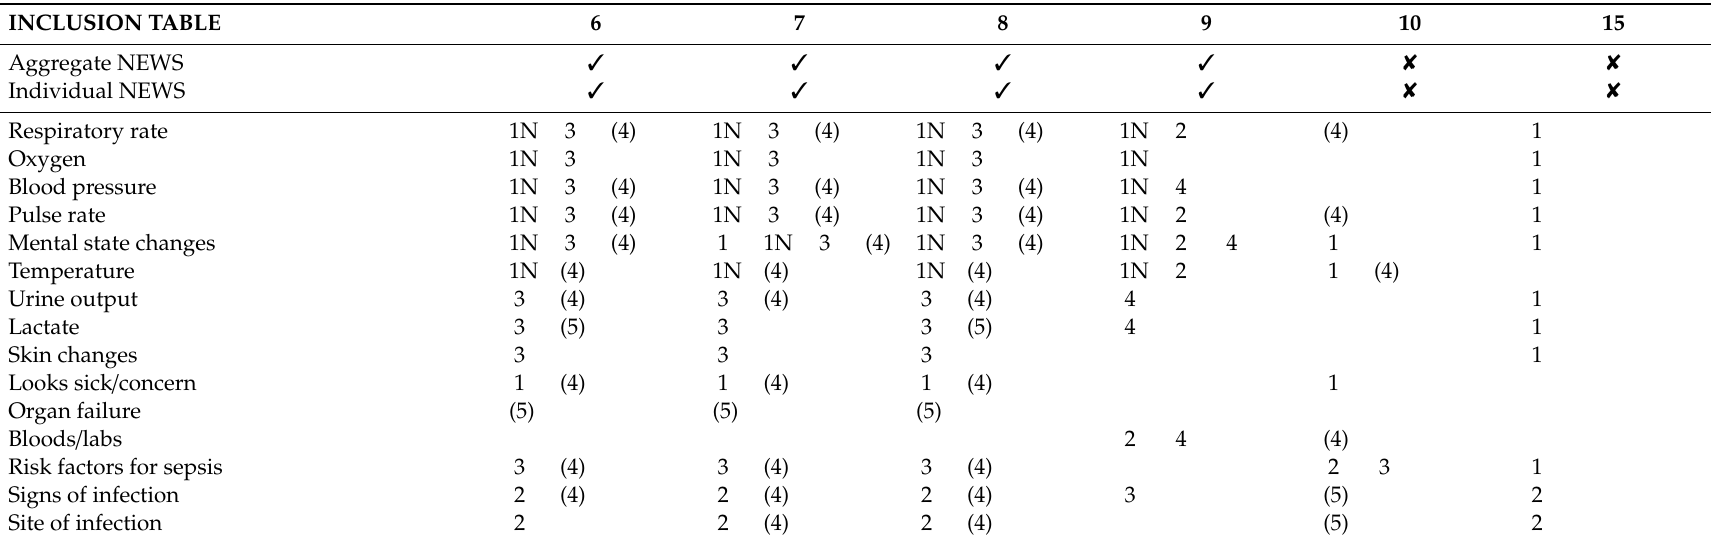
Table A5. Items included in each guideline by step (Trusts